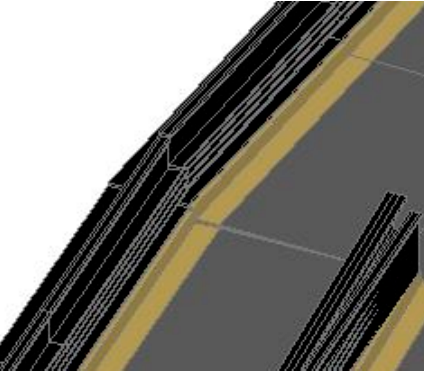
Figure 5. View of the guardrail showing edgier alignment.